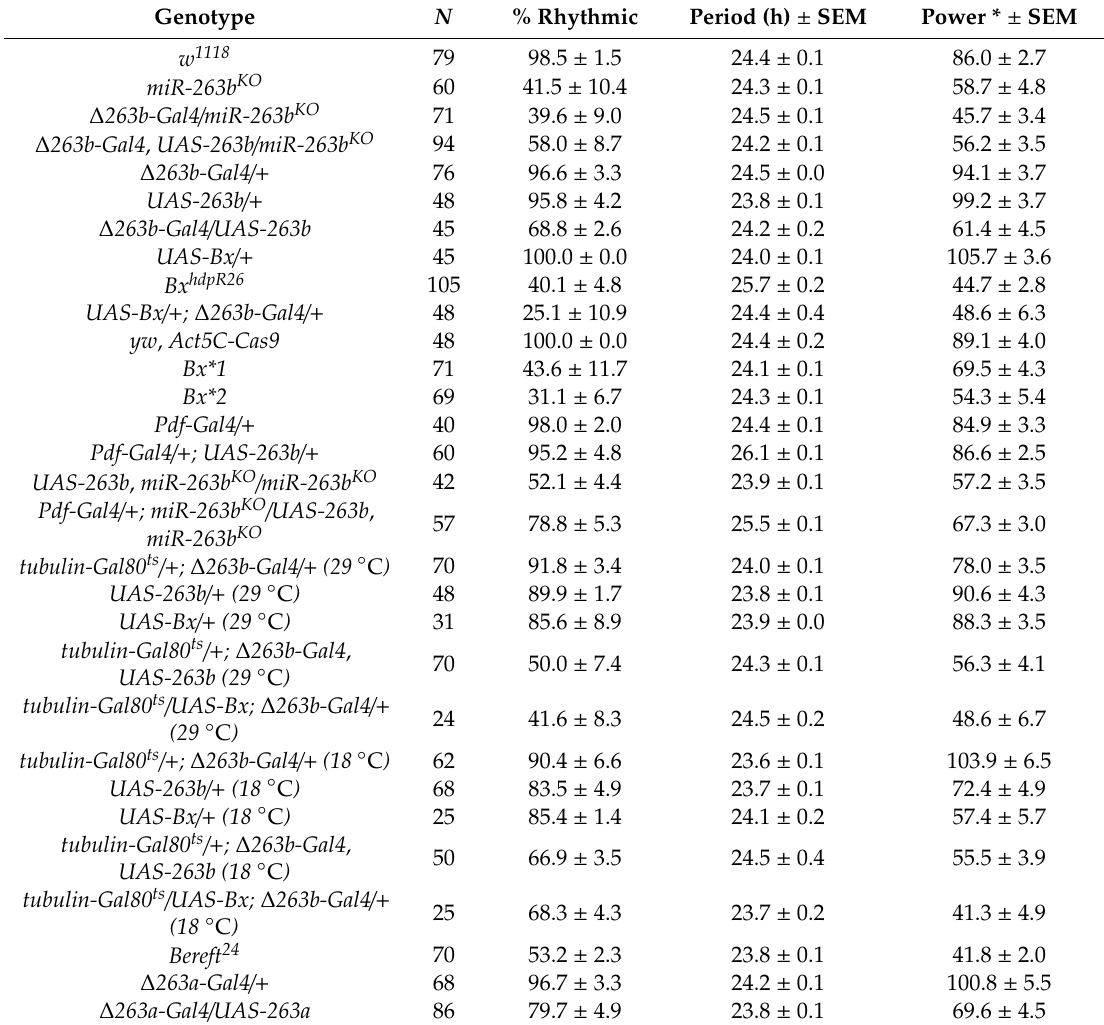
Table 1. Locomotor activity of flies with altered miR-263b and Bx levels in constant darkness (DD). SEM—standard error of the